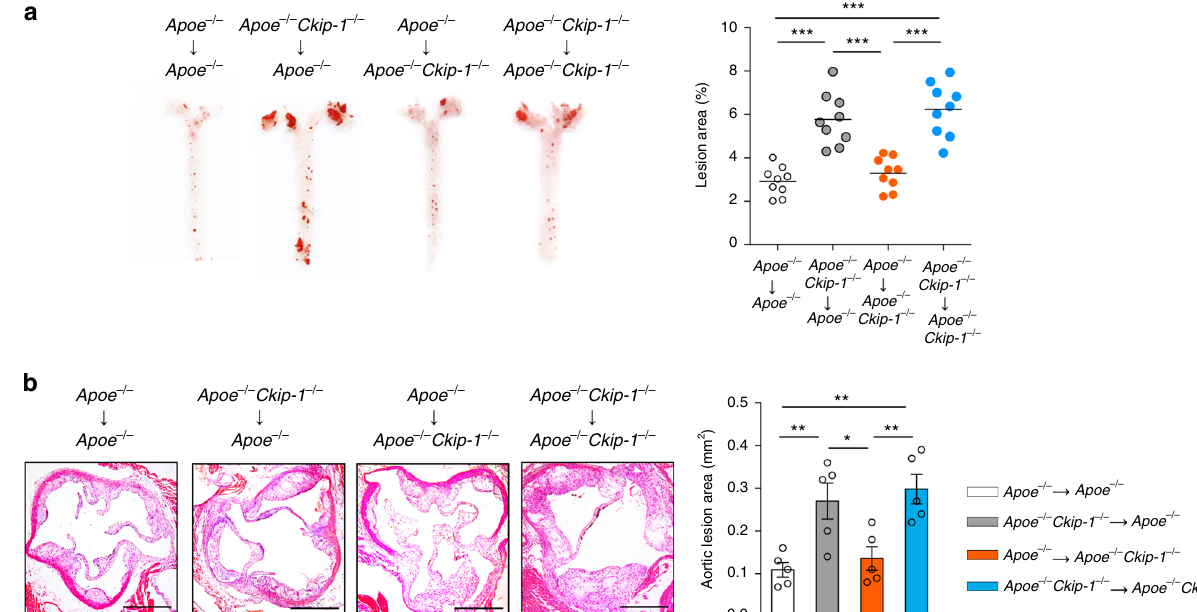
Fig. 7 Deletion of Ckip-1 in hematopoietic cells is responsible for the increased atherosclerosis in Apoe − / − Ckip-1 − / − mice. a Bone marrow transfers were performed in 6-week old lethally irradiated Apoe − / − and Apoe − / − Ckip-1 − / − mice followed by reconstitution with bone marrow from Apoe − / − or Apoe − / − Ckip-1 − / − mice, respectively. Representative images of Oil Red O-stained aortas of each group chimeras and quanti fi cation of lesion area are shown, n = 9. b Representative images of cross-sections of the aortic roots from each group stained with H&E and quanti fi cation of aortic root lesion area are shown. Scale bar, 500 μ m. n = 5. Data represent mean ± s.e.m. P values were calculated by two-tailed Student ’ s t -test ( a , b ). * P < 0.05, ** P < 0.01, *** P <